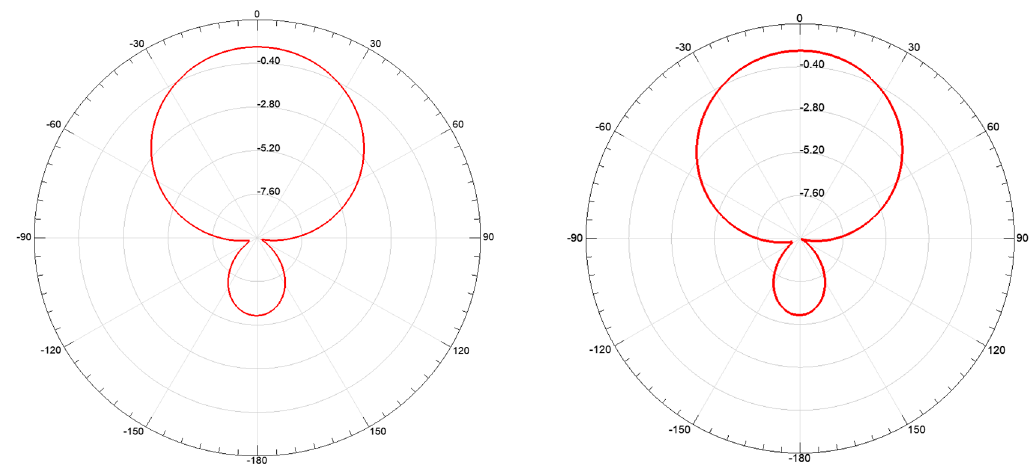
Figure 10. Radiation pattern diagram at 1.21 GHz: xz-plane ( left ) and yz-plane ( right ).